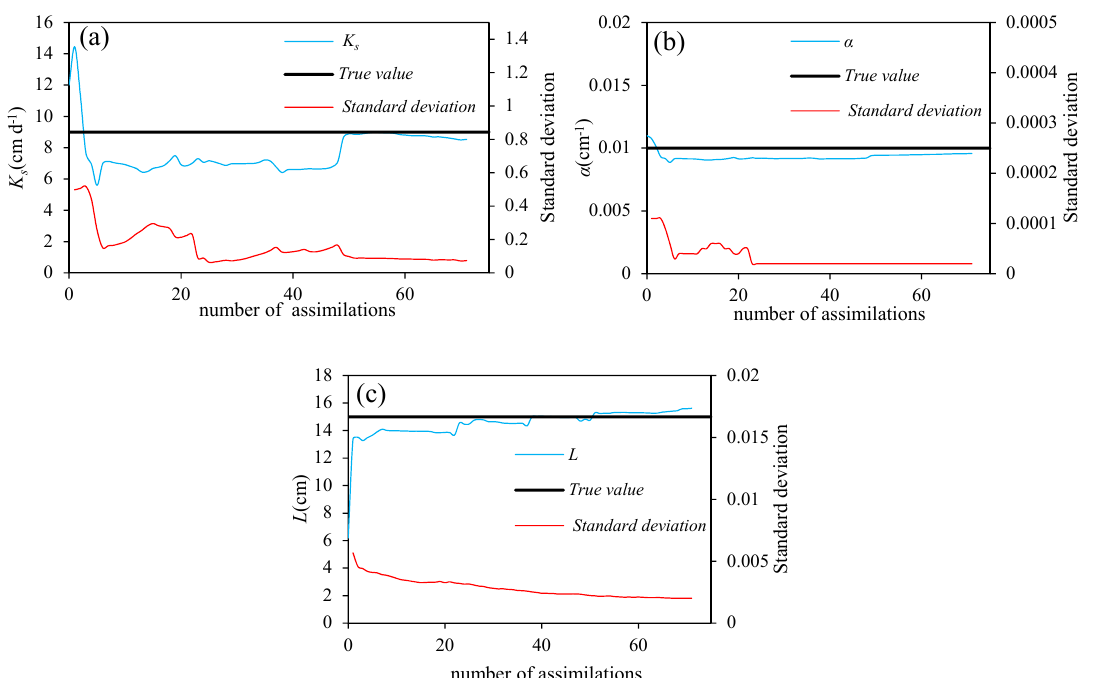
Figure 2. Evolution of the estimated hydraulic conductivity ( K s ), shape parameter ( α ), and longitudinal dispersivity ( L ) values using EnKF.